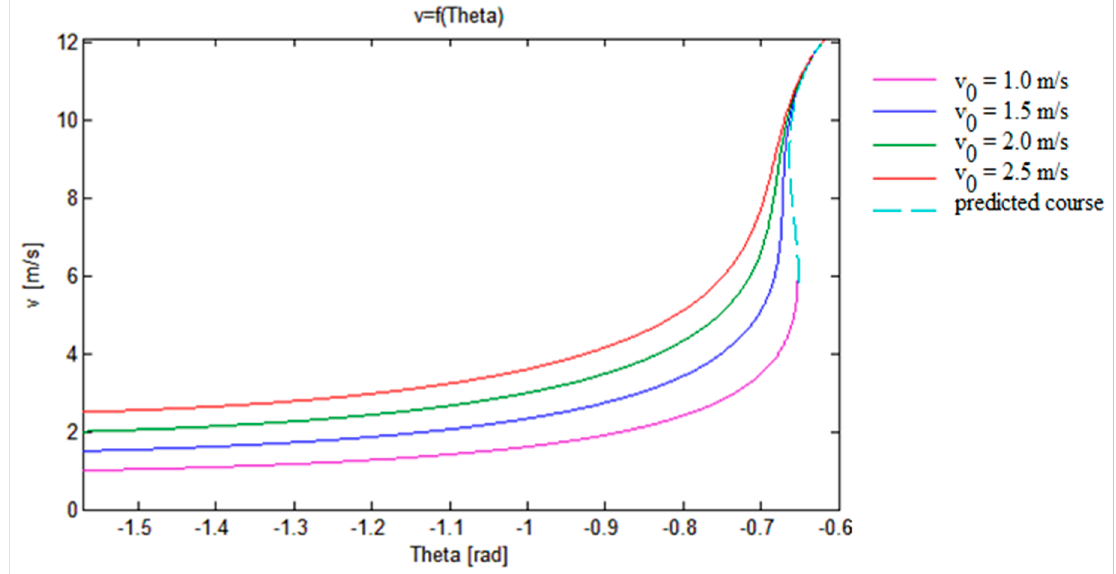
Figure 6. A prediction of the run of a velocity hodograph function for incorrect solutions.